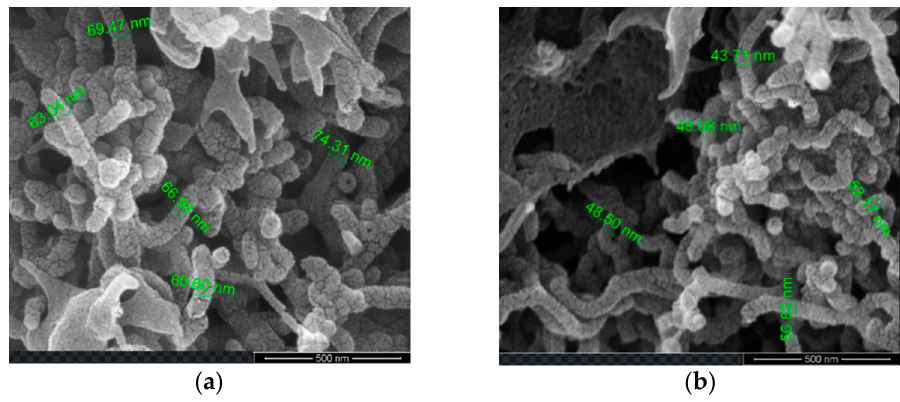
Figure 6. SEM images of MWCNTs/PPy nanocomposite: ( a ) PPC-0.3, ( b ) PPC-0.05.